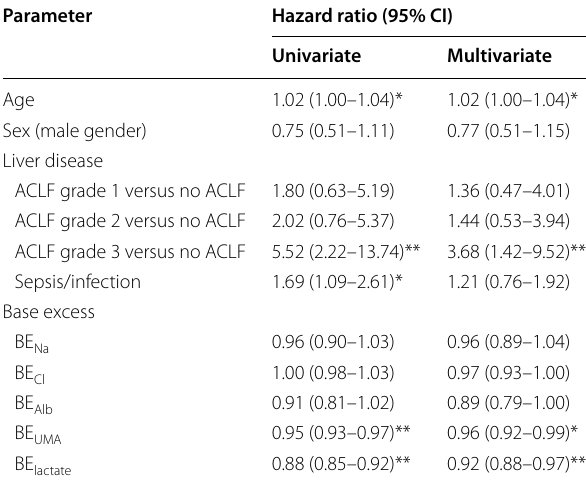
Table 4 Cox regression model for risk factors for mortality in critically ill patients with liver